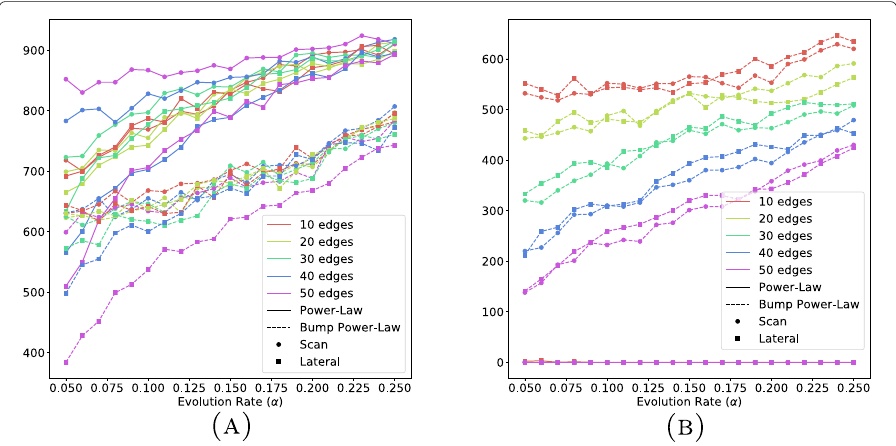
Fig. 9 Relative Performance of RH and KS Anomaly Scores. a RH versus KS. b RH versus Edit. a RH versus KS. b RH versus